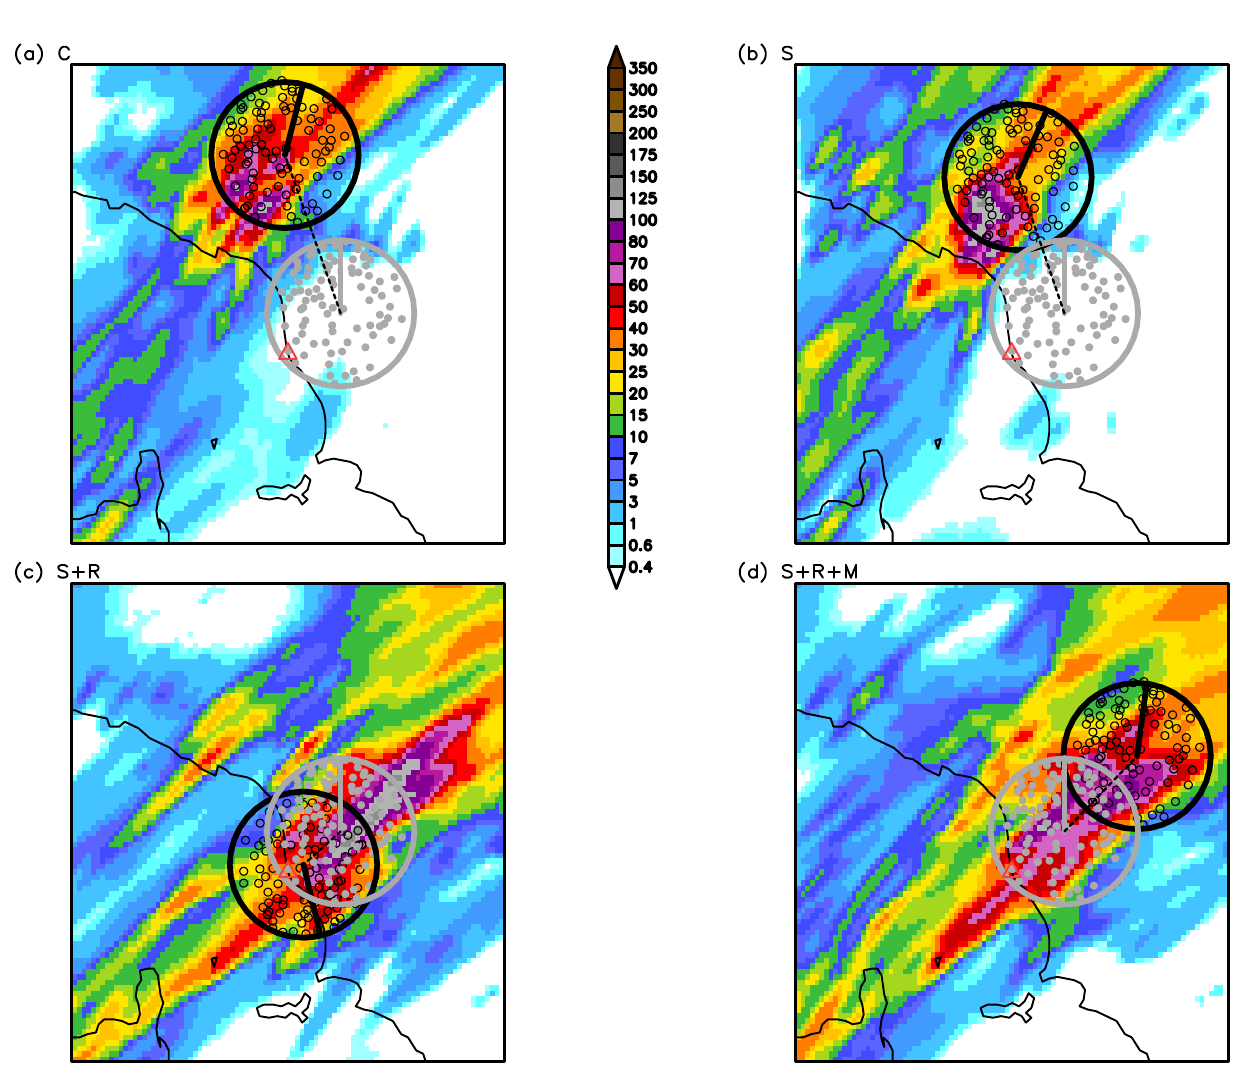
Figure 8. Rainfall forecast accumulated in the 6 h period ending on 0300 UTC, 10 September 2017 (shaded colors, unit mm): ( a ) control run C , ( b ) assimilated run S , ( c ) assimilated run S + R , ( d ) assimilated run S + R + M . The black circles are the outputs of the roto-translations of the gray circles, minimizing the RMSE of the rainfall with respect to the values measured by the 91 rain gauges covering the area mostly affected by the heaviest precipitation (rain gauge positions indicated in gray). The dashed segments indicate the distances between the centers of the black and gray circles. The solid black segment shows the rotation of the circle with respect to north, counterclockwise. The red triangle (“ (cid:52) ”) indicates the Livorno township. In each panel, the gray circle indicates the area containing the 91 rain gauges